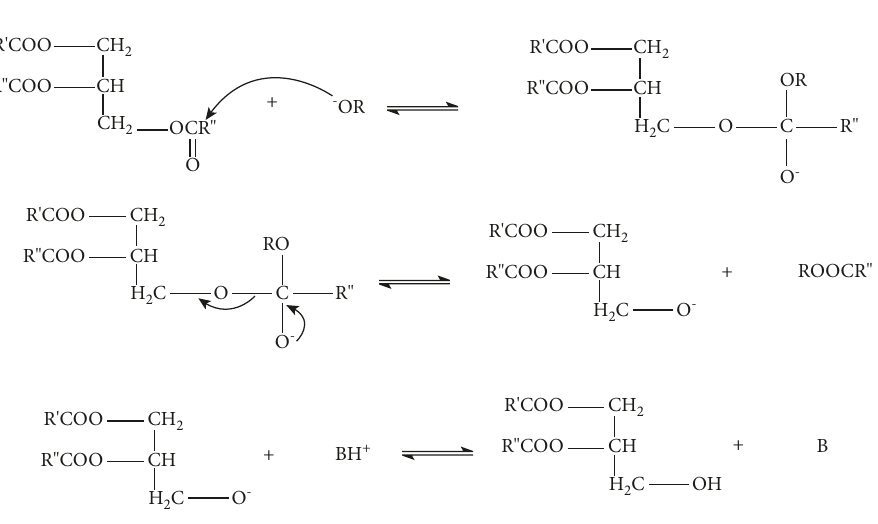
Figure 4: The reaction mechanism of base catalyst [51].